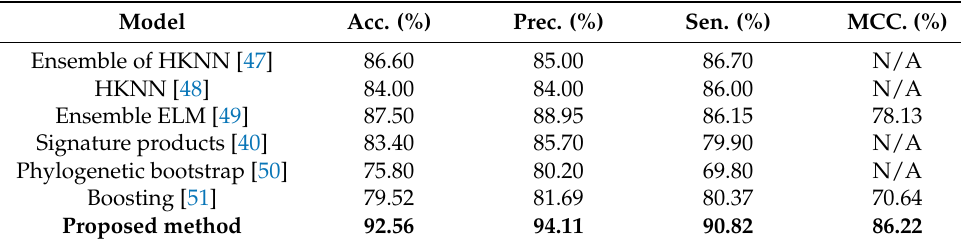
Table 8. Comparison results of different methods on H. pylori .